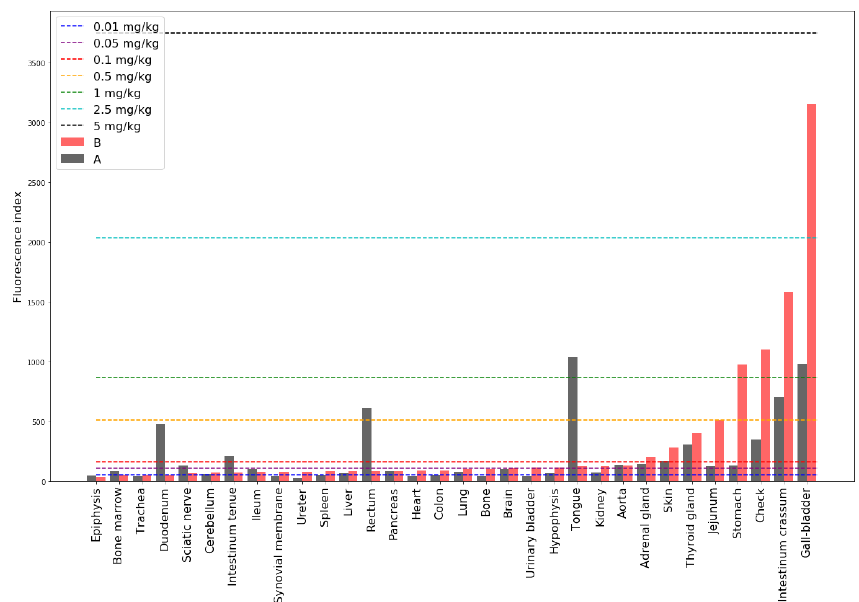
Figure 7. Fluorescence indices of organs of Primates A (3 h after administration) and B (24 h after administration). Fluorescence indices corresponding to phantoms with known concentration are shown by dotted